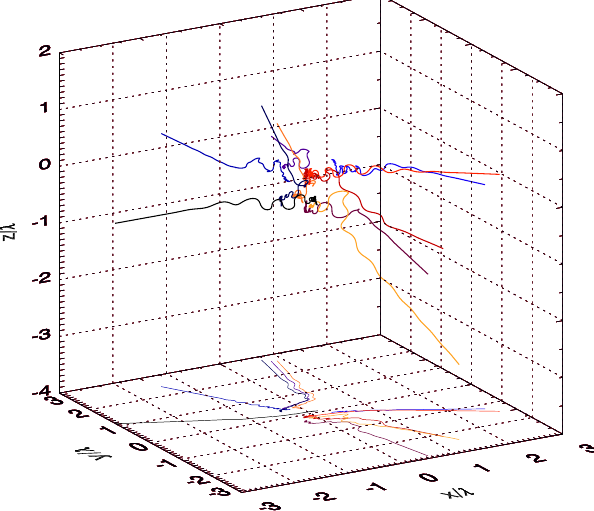
Figure 1. The trajectories of ten stray electrons driven by two tightly-focused counter-propagating laser pulses. The displayed electron trajectories correspond to the temporal interval 0 < t < 36.5 T , where T = λ / c ≈ 2.67 fs and λ = 0.8 μ m are the laser period and wavelength, respectively. Each laser pulse has P = 500 PW power and w 0 = 1 λ waist radius, which implies an intensity I ≈ 4.8 × 10 25 W/cm 2 . The projection of the trajectories on the focal plane xy is also